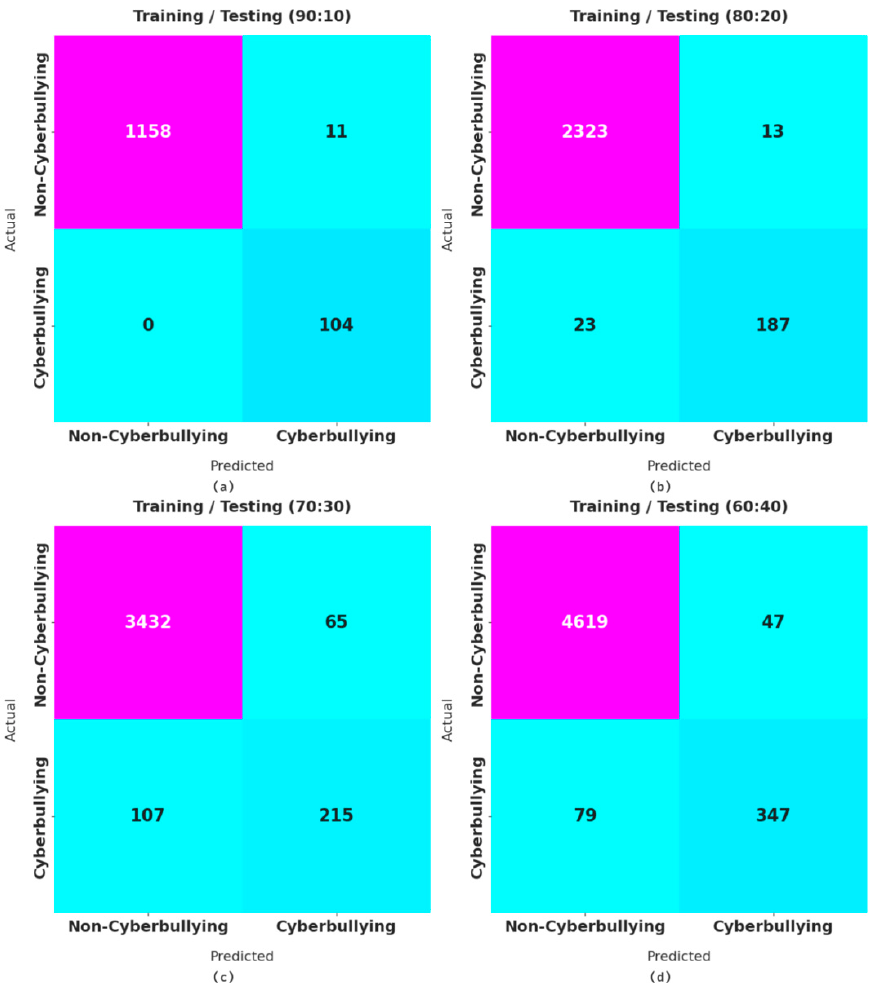
Figure 3. Confusion matrix of the proposed model for different training/testing dataset sizes. Where ( a ) considers 90:10 training/testing data split, ( b ) considers 80:20 training/testing data split, ( c ) con- siders 70:30 training/testing data split, and ( d ) considers 60:40 training/testing data split.